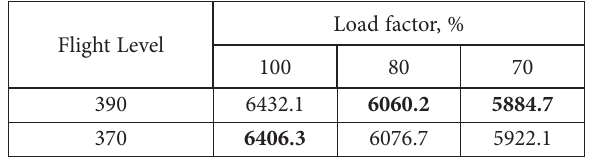
Figure 3. Fuel saving potential for ‘Deteriorated engines’ airplane at 3000 km flight